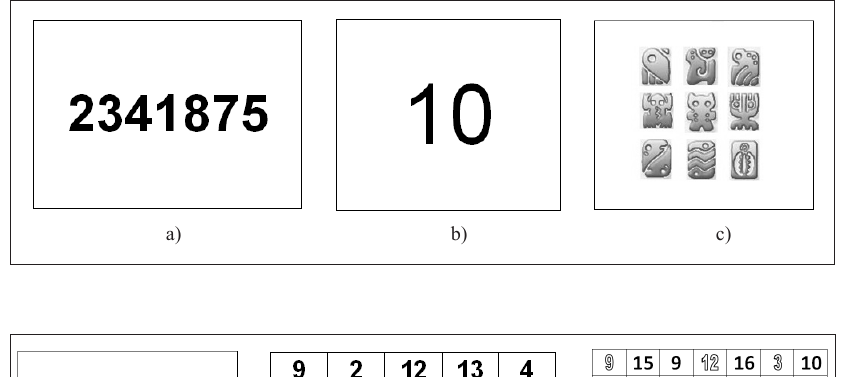
Figure 2. Tests for attention assessment